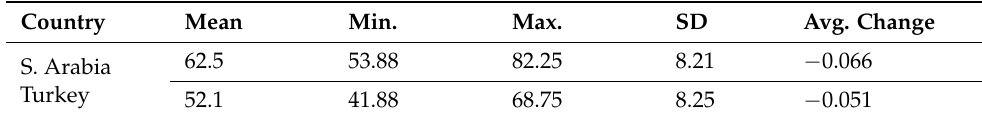
Table 2. Descriptive statistics for monthly CR